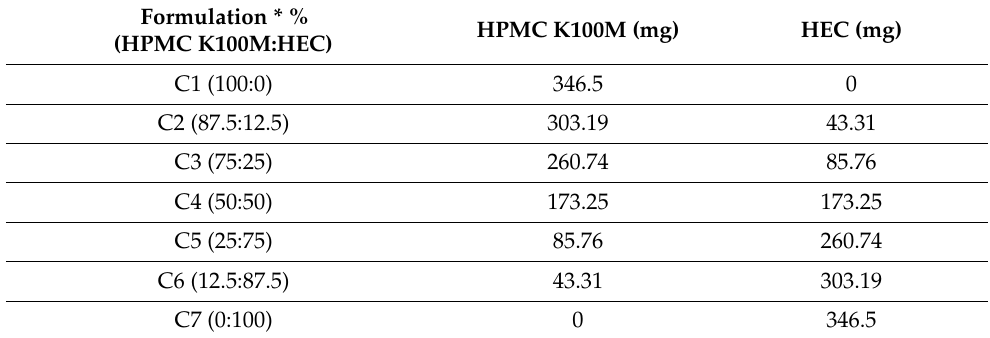
Table 15. The formulations of C1 to C7.